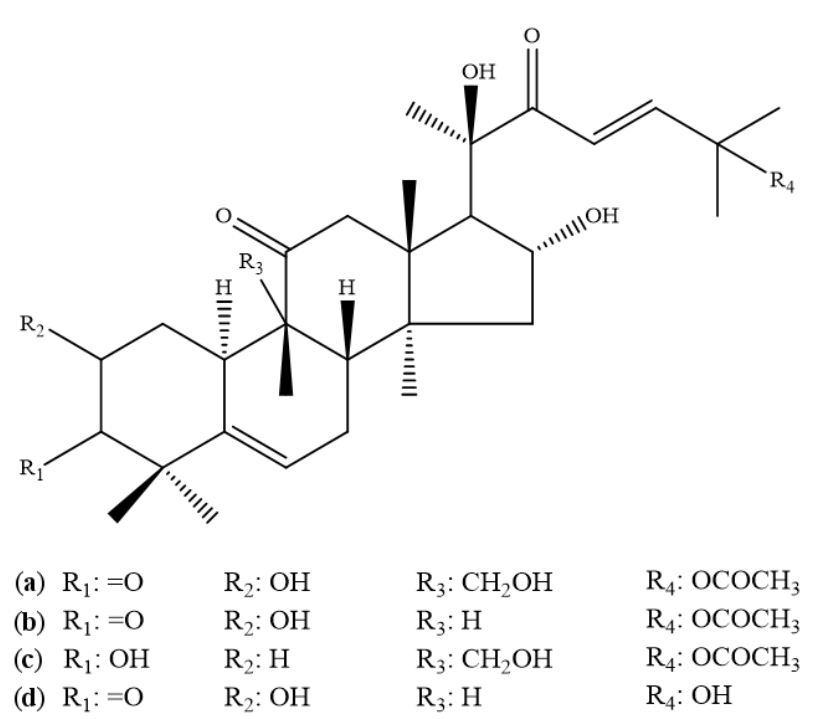
Figure 2. Structure of different cucurbitacin: ( a ) Cucurbitacin A, ( b ) Cucurbitacin B, ( c ) Cucurbitacin C and ( d ) Cucurbitacin D.